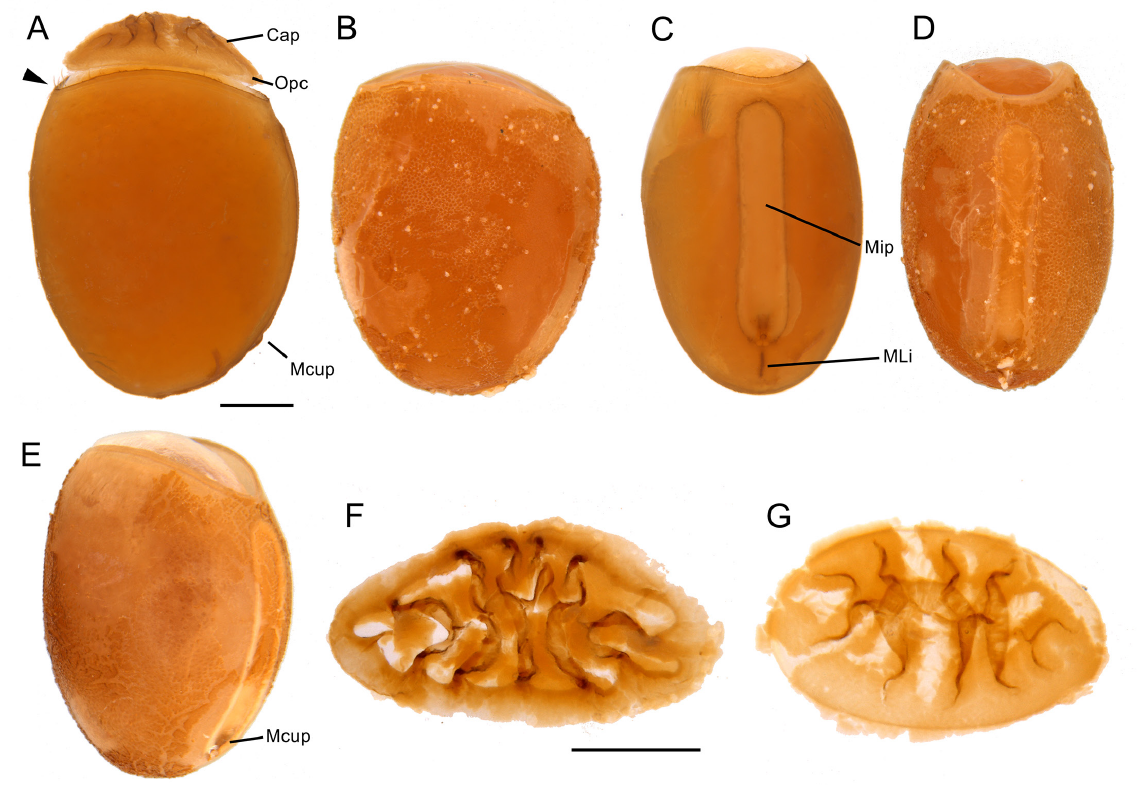
Fig. 33. Arumatia aramatia Ghirotto gen. et sp. nov., egg morphology from the holotype female. A–B . Lateral view, arrowhead pointing at bristles on opercular collar (A). C–D . Dorsal